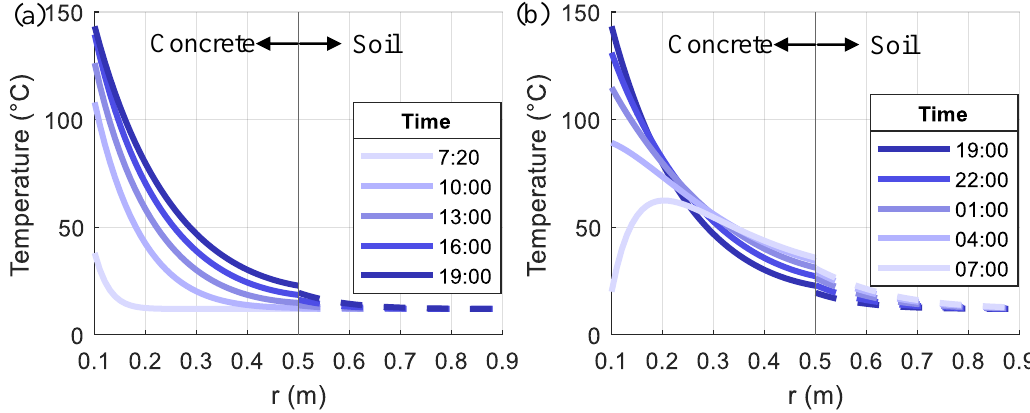
Figure 9. Temperature distribution in the 1st loading cycle: ( a ) 7:00 to 19:00; ( b ) 19:00 to 7:00.